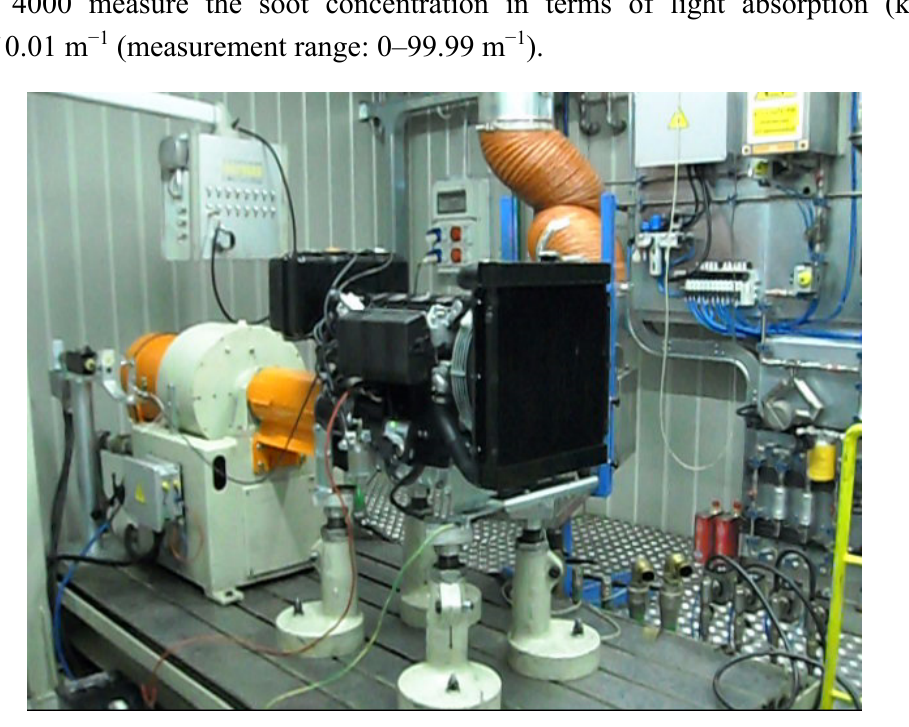
Figure 1. The Lombardini engine at the test